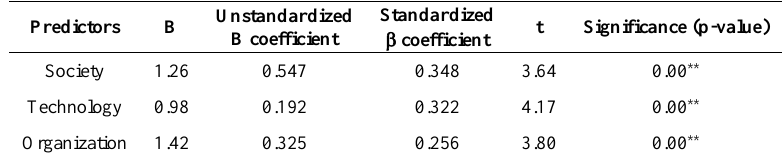
Table 13. Regression results in the impact of digital transformation on the construction and improvement of the quality